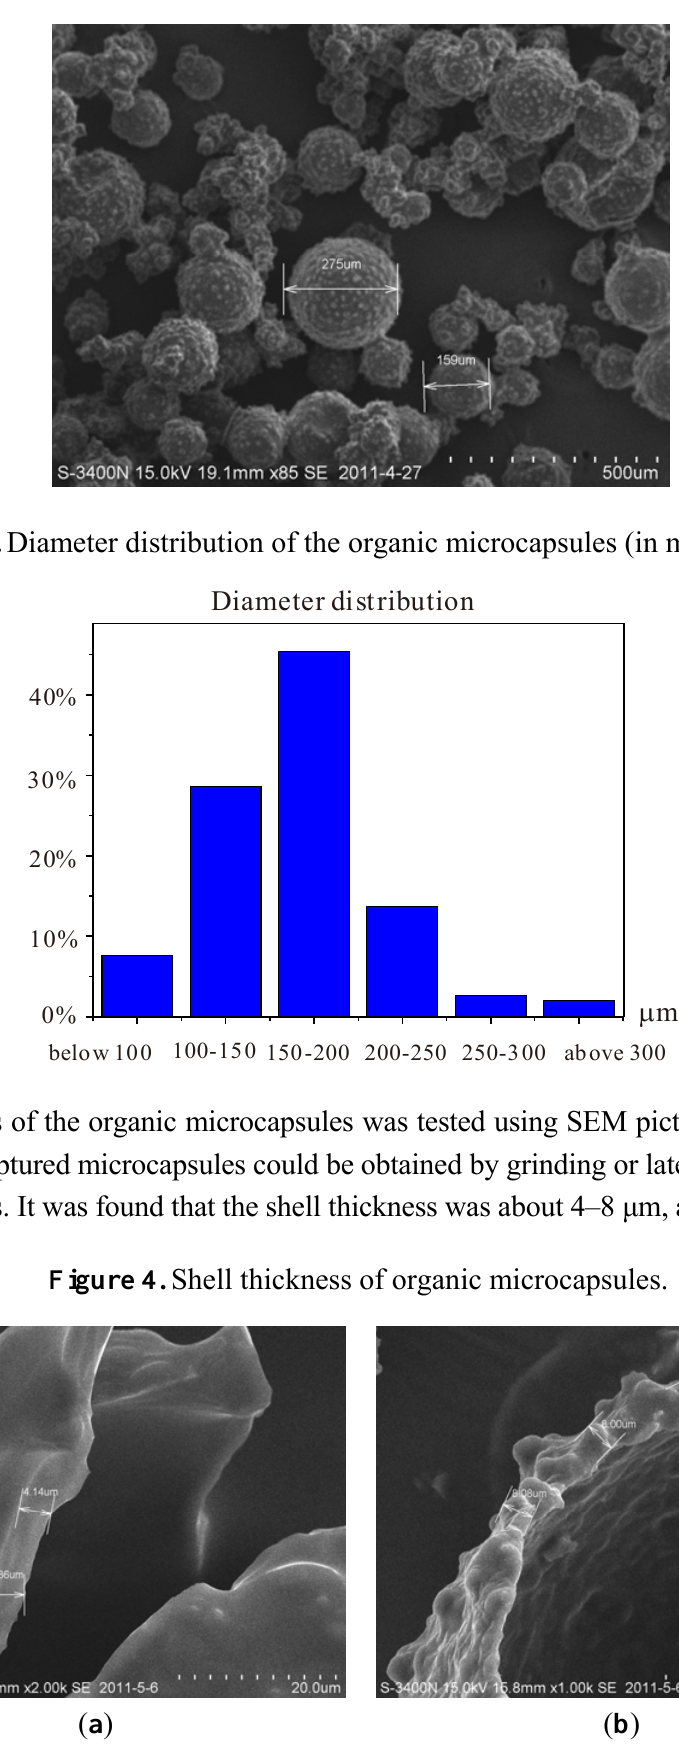
Figure 2. Organic microcapsules under a scanning electron microscope (SEM).